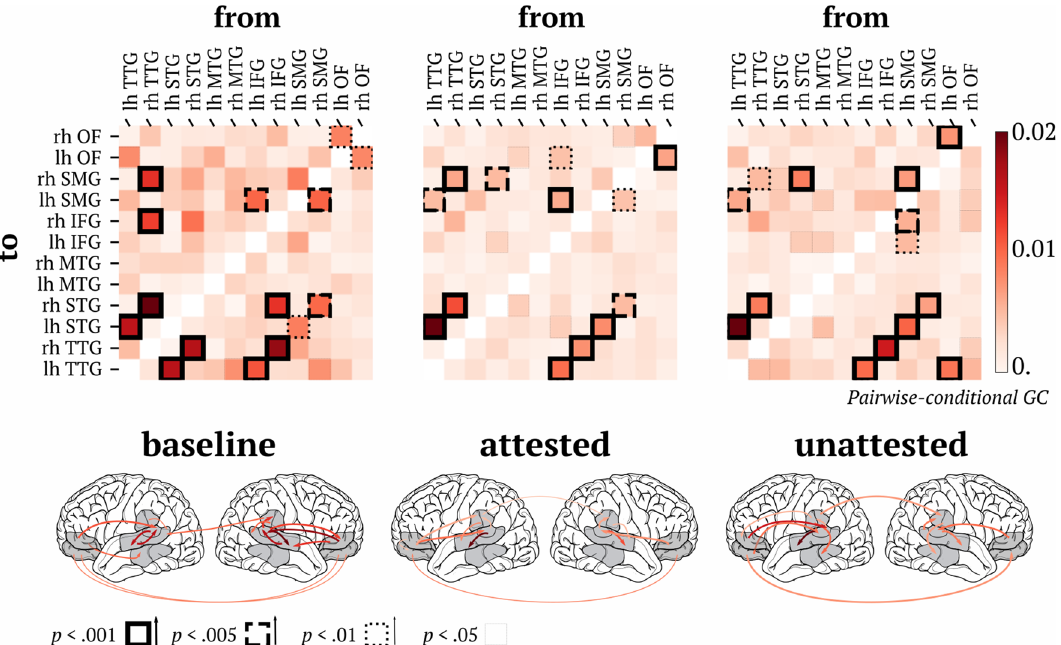
Figure 4. Connectivity patterns across regions bilaterally. In the matrices, the shade of red indicates the Granger causality value of the connections, and the border of the squares the significance level: solid bold line = p < .001; bold dashed line = p < .005; thin dashed line = p < .01; solid thin line = p < .05. The brain models underneath each matrix show the location of the connections with a significance of p < .01 or greater. The legend at the bottom indicates that the shade of the line corresponds to strength of the causal connection, using the same colorbar above, and the thickness to statistical